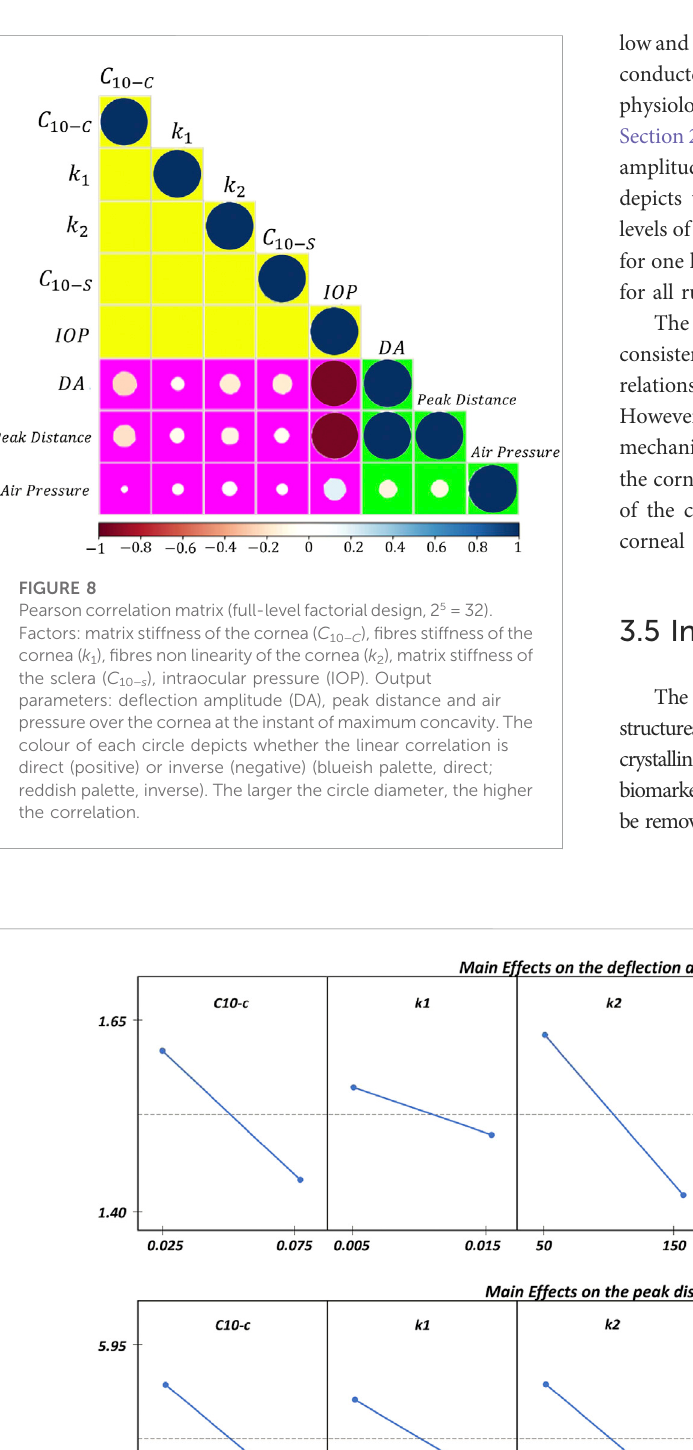
Frontiers in Bioengineering and